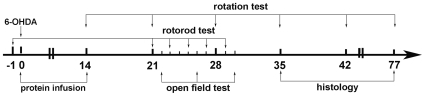
Schematic time line of the experimental design.Stereotaxically administrations of N-SYN, SYN and N-GFP into the right substantia nigra were processed from day 0 to 14, and single injection of 6-OHDA was processed on day 0. The open field test was conducted after 21 days post-surgery. The rotorod test was conducted 1 day before and 21 days after stereological surgery. The rotation test was conducted on day 14, 21, 28, 35, 42, 77. Histology was processed on 5 weeks and 11 weeks postsurgery.